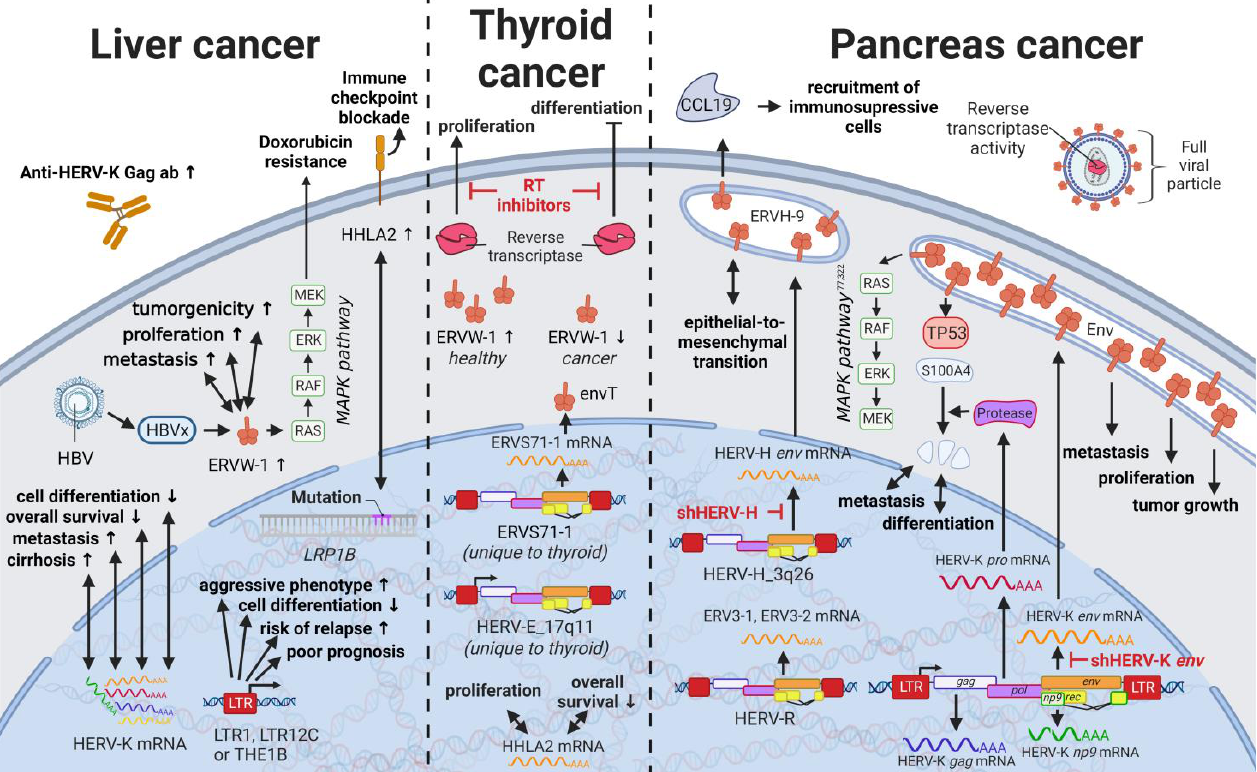
Figure 7. The role of HERVs in liver and endocrine cancers. Evaluated treatments are marked in red. Abbreviations: HBV = hepatitis B virus, MAPK = MAP kinase, ab = antibody, LTR = long terminal repeat, gag = group antigen (capsid), pol = polymerase, RT = reverse transcriptase, env = envelope, HERV-K =